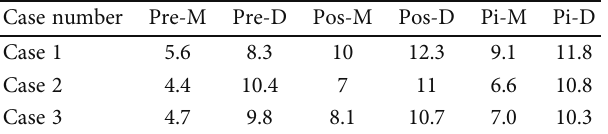
Pre-M: pre-op mesial, Pre-D: pre-op distal, Pos-M: post-op mesial, Pos-D: post-op distal, Pi-M: post-implantation mesial, Pi-D: post-implantation